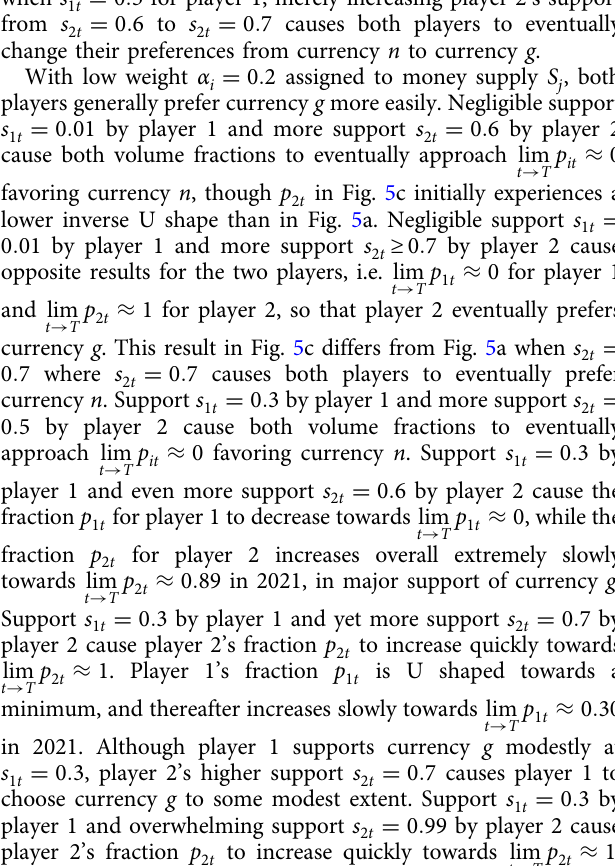
(cid:4) 0 : 99. a α ¼ 0 : 6 and b α ¼ 0 i i it